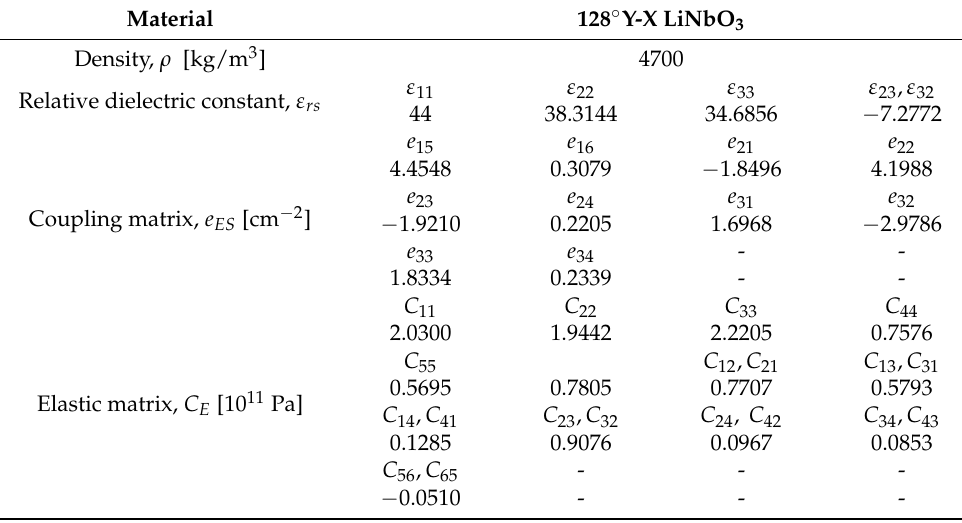
Table 2. Parameters of piezoelectric materials used in the simulation model.